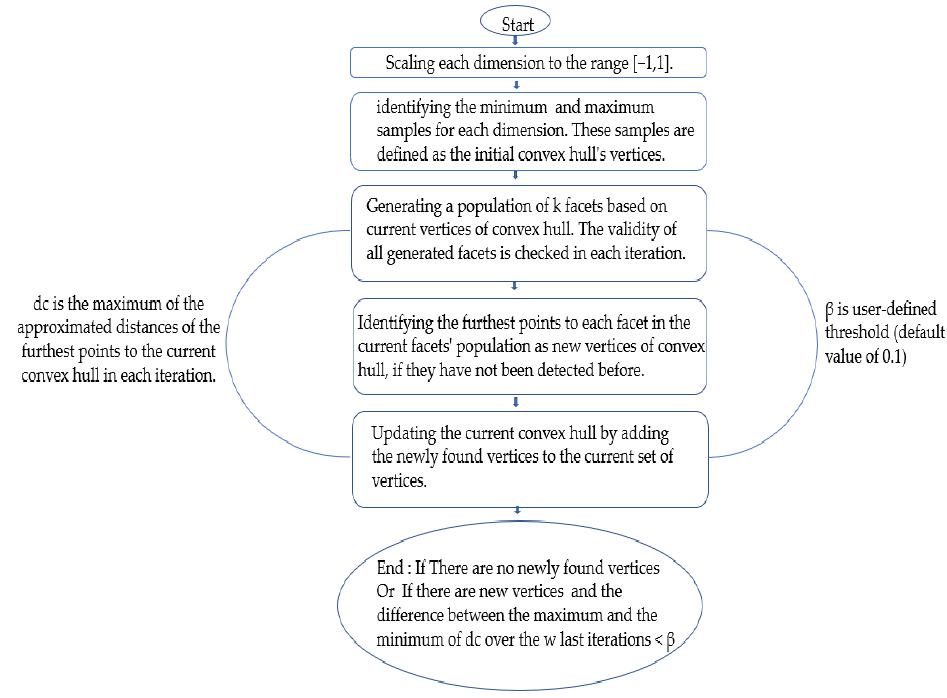
Figure 1. ApproxHull algorithm flowchart. Adapted from reference [62].